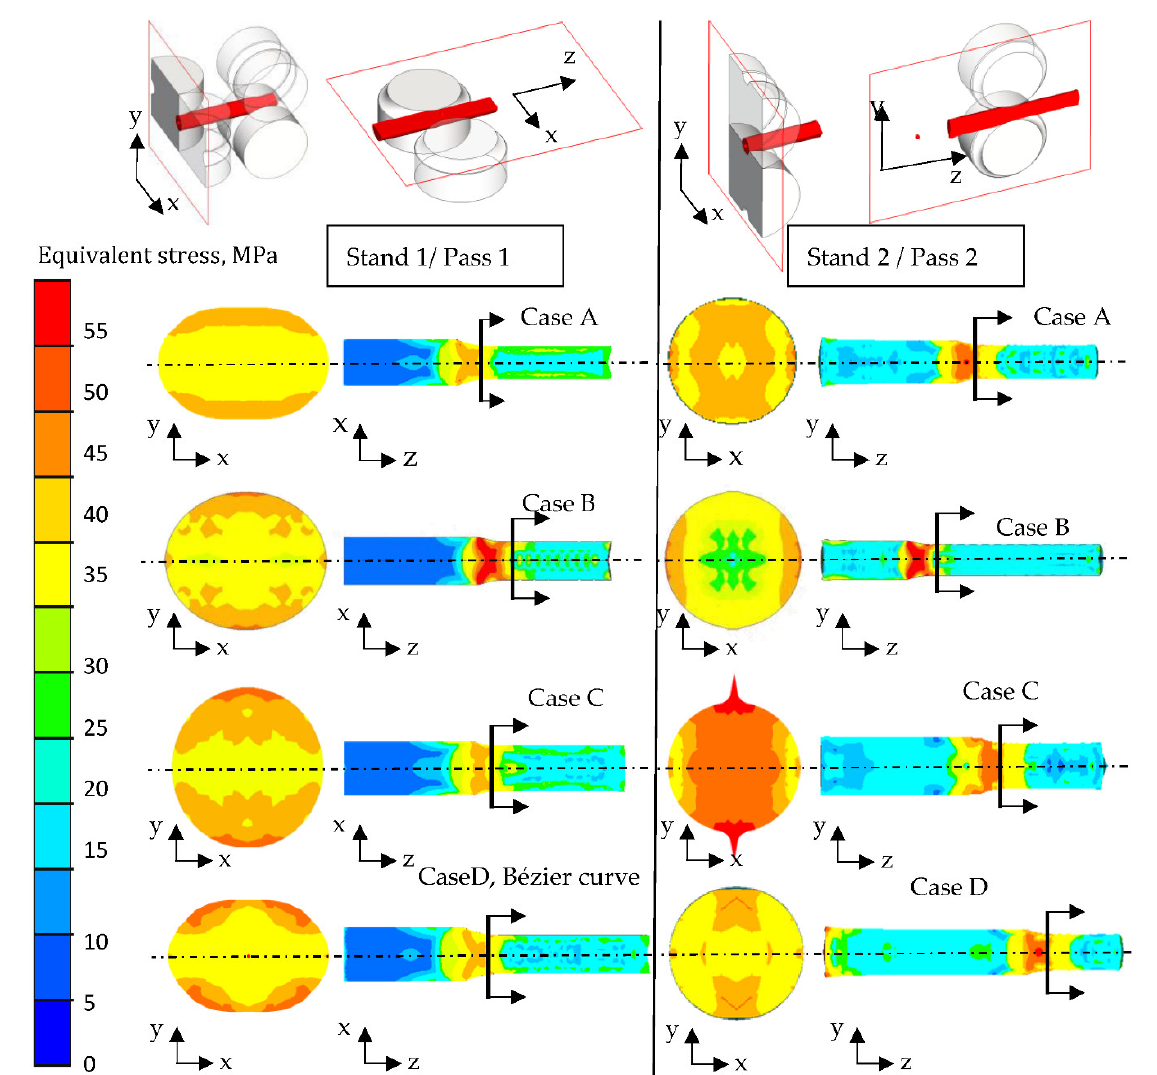
Figure 6. The equivalent stress distributions at the cross sections along the vertical direction and the rolling direction.